Question: Which kind of chart has been used to present this data?
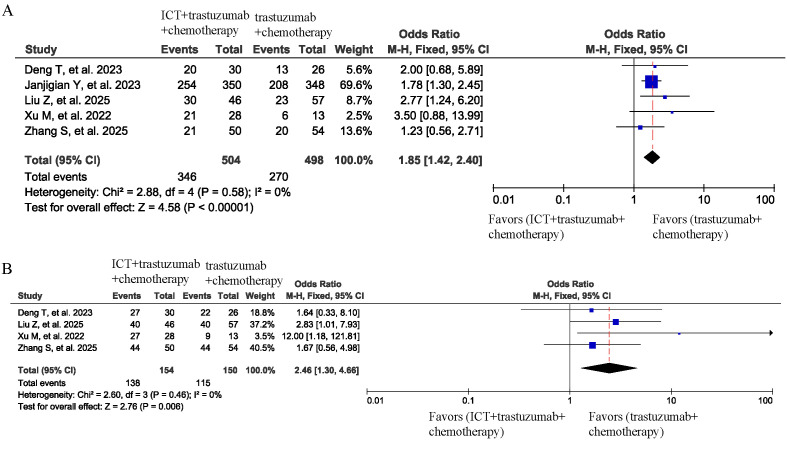
Answer: forest